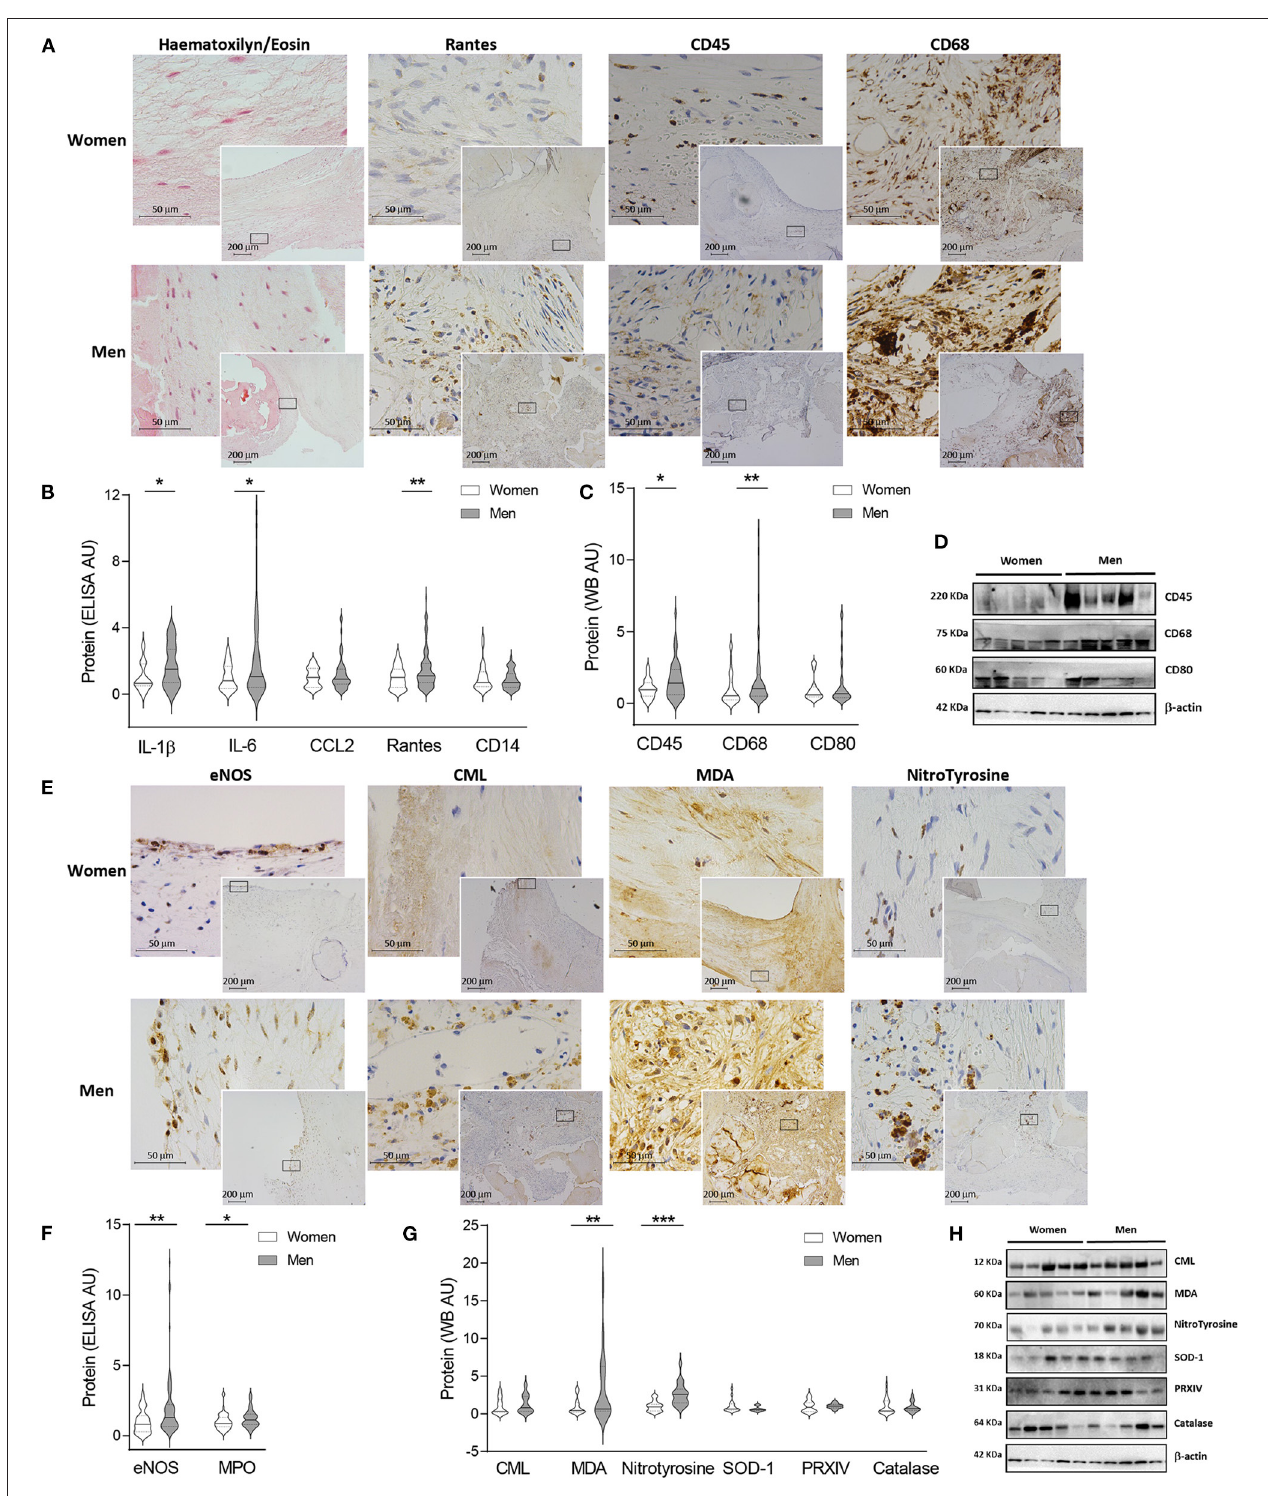
FIGURE 1 | Sex differences in inflammation and oxidative stress markers in AVs from AS patients. Representative microphotographs of AV sections from AS patients stained for haematoxylin/eosin, and immunostained for Rantes, CD45 and CD68 (from left to right) in women and men AV tissue (A) . Protein expressions from different inflammation markers in tissue homogenates from AVs of AS patients measured by ELISA (B) and western blot (C) . Representative images for inflammatory markers measured by western blot (D) . Representative microphotographs of AV sections from AS patients immunostained for eNOS, CML, MDA, and Nitrotyrosine (from left